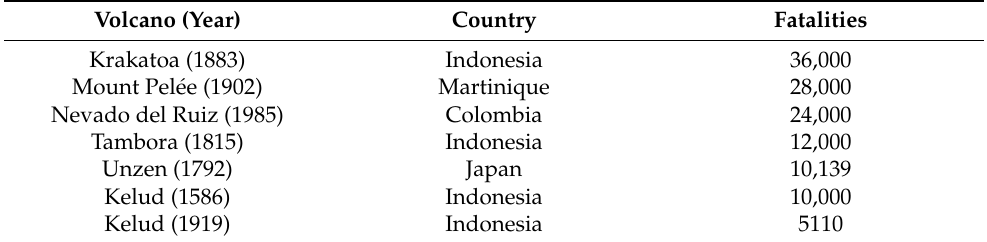
Table 1. List of most enormous fatalities due to volcanic eruptions since 1500 (source: Ref. [59]). Volcano (Year) Country